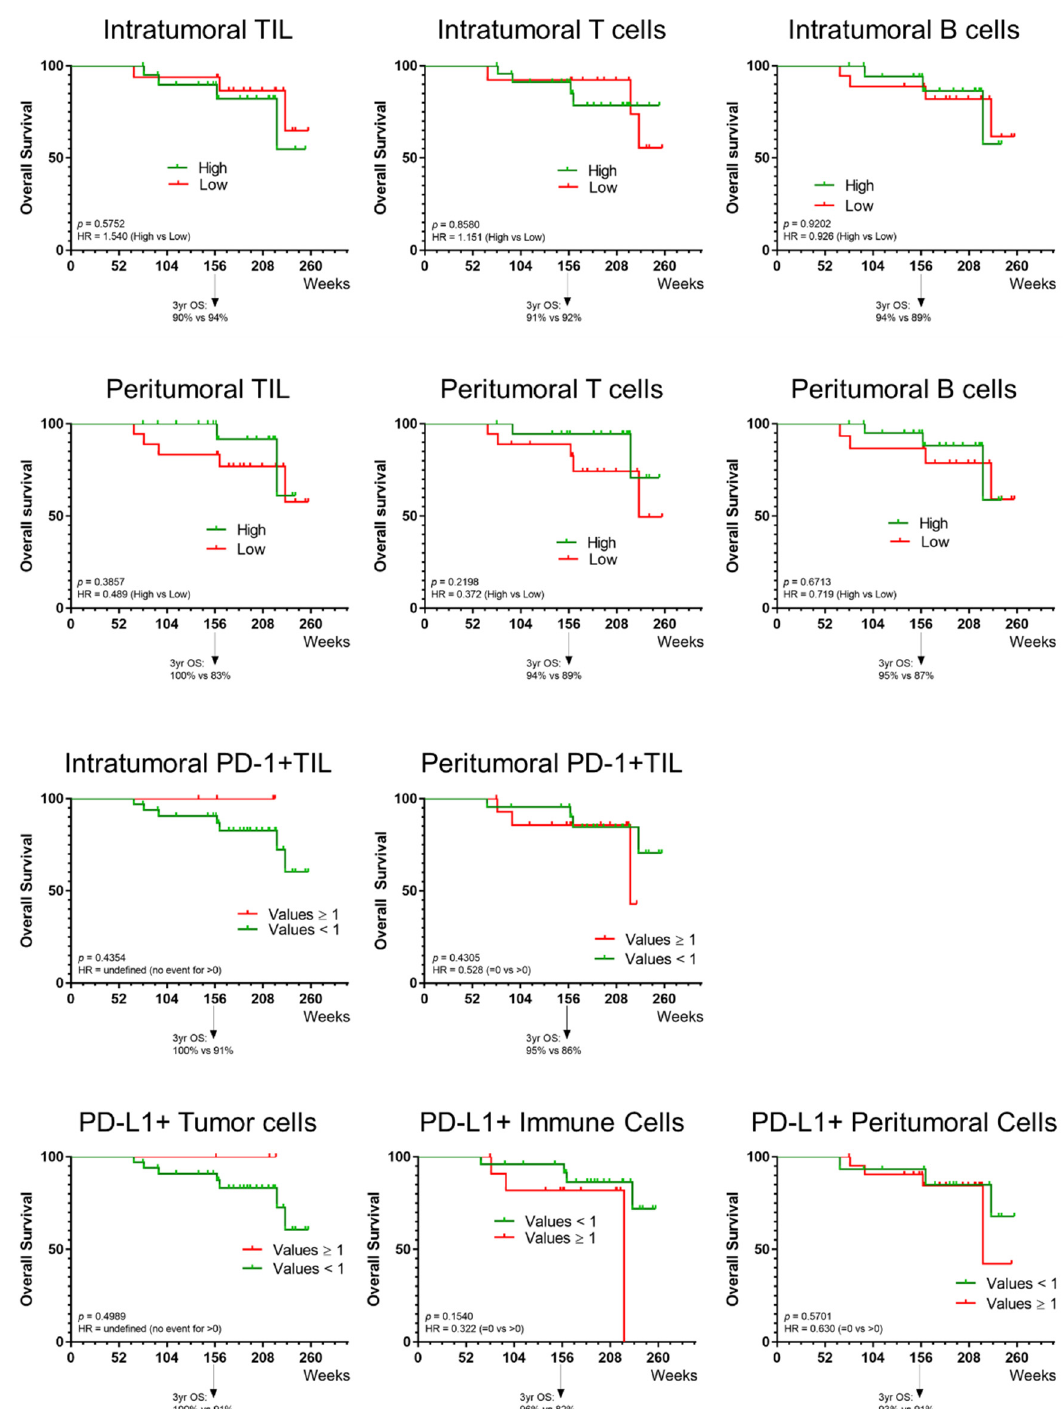
Figure A2. Tumor-infiltrating lymphocytes and prevalence of PD-1 and PD-L1 expression on cells in melanoma metastases and the potential correlation with survival outcomes. Kaplan–Meier estimates of OS for intratumoral TIL (both CD3 + T cells and CD20 + B cells), CD3 + T cells and CD20 + B cells. Kaplan–Meier estimates of OS for peritumoral TIL (both CD3 + T cells and CD20 + B cells), CD3 + T cells and CD20 + B cells. No association was observed between immune subpopulations and OS. Kaplan–Meier estimates of OS for PD-L1 + and PD-1 + cells. No association was observed between cells expressing PD-1 or PD-L1 and OS. The arrow indicates the 3-year survival rate.